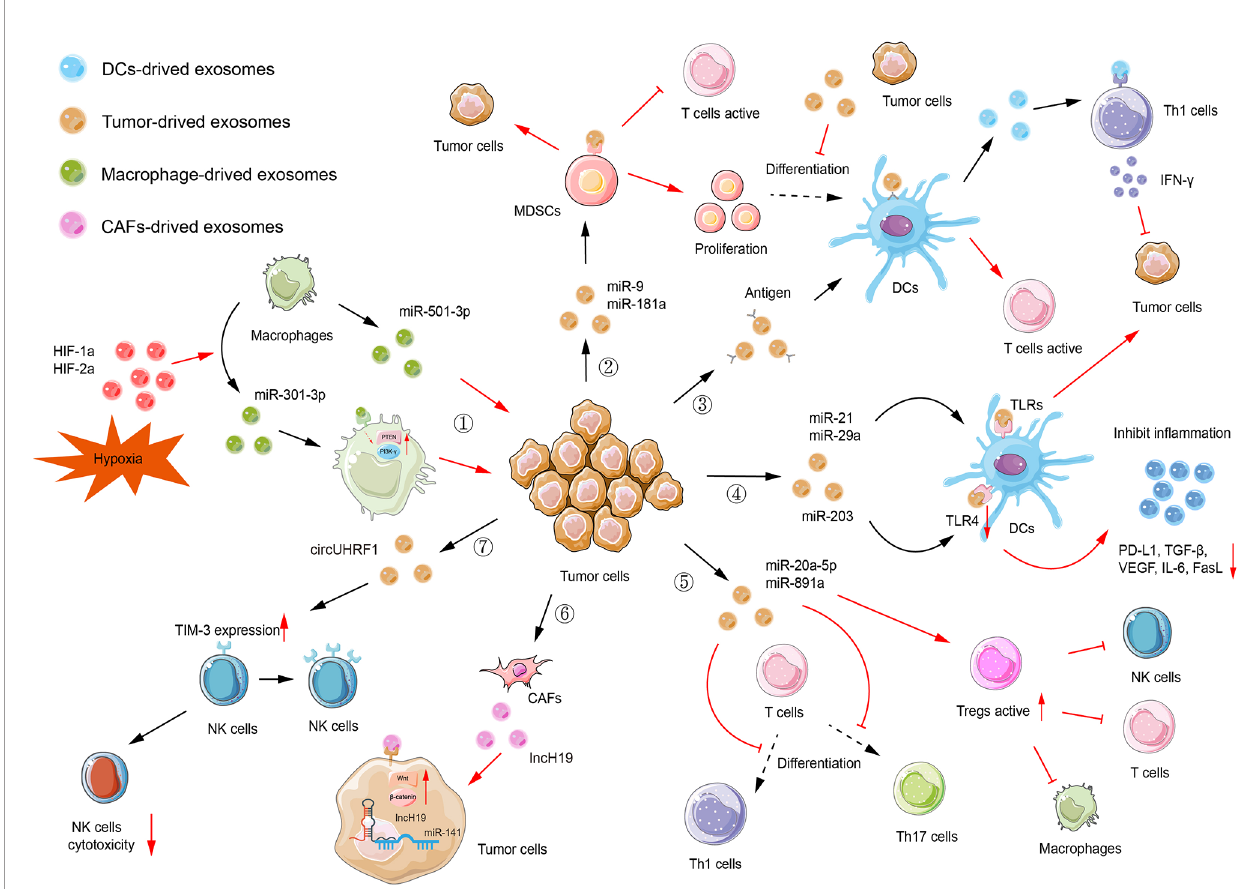
FIGURE 3 | Exosomal ncRNAs-mediated immune regulation. (1) Macrophages-derived exosomal miR-501-3p facilitates tumor invasion and metastasis. Hypoxia can upregulate miR-301a-3p expression by modulating HIF-1a and HIF-2a, thus inhibiting the PTEN/PI3K- g signaling pathway and promoting tumor invasion, migration, and epithelial-mesenchymal transition (EMT). (2) Tumor-derived exosomal miR-9 and miR-181a consequently affect proliferation of myeloid-derived suppressor cells (MDSCs) to promote tumorigenesis. Also, these MDSCs inhibit the activation of T cells. (3) Antigens can be encapsulated in exosomes and delivered to dendritic cells (DCs). Then, DCs activate T cells to initiate the immune response. Tumor-derived exosomes can inhibit the differentiation of MDSCs into DCs. DCs-derived exosomes facilitate the release of IFN- g , which subsequently inhibits tumorigenesis. (4) Tumor-derived exosomal miR-21 and miR-29a can target TLRs to provoke pro-tumoral in fl ammation, rendering tumor growth and metastasis. Tumor-derived exosomal miR-203, targeting TLR4 in DC cells, downregulated the expression of TLR4 and related cytokines, such as PD-L1, TGF- b , and VEGF. (5) Tumor-derived exosomal miR-20a-5p and miR-891a inhibit Th1 and Th17 cell differentiation while increasing the activity of regulatory T cells (Tregs). (6) CAF-derived exosomal lncH19 can be transferred into tumor cells to activate Wnt/ b -catenin signaling via serving as a ceRNA for miR-141. (7) Tumor-derived exosomal circUHRF1 can elevate the expression of TIM-3 on the surface of NKs, thus inhibiting the cytotoxicity of